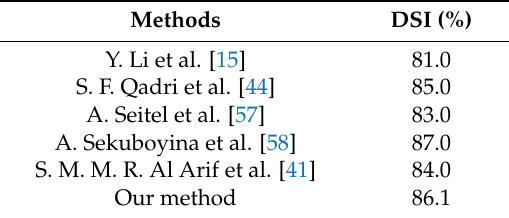
Table 4. Our method compared with state-of-the-art methods on vertebrae